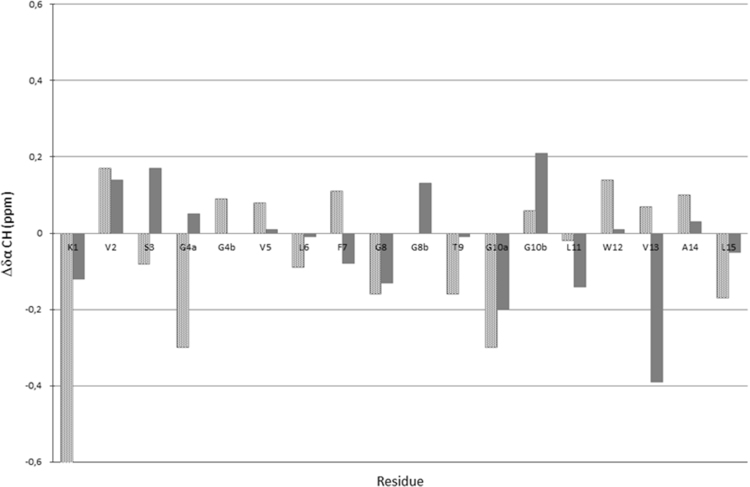
Comparison of deviations of αCH proton chemical shifts from random coil values [8] for MTP1 in DMSO (dotted bars) and TFE/H2O 1:1 (gray bars).